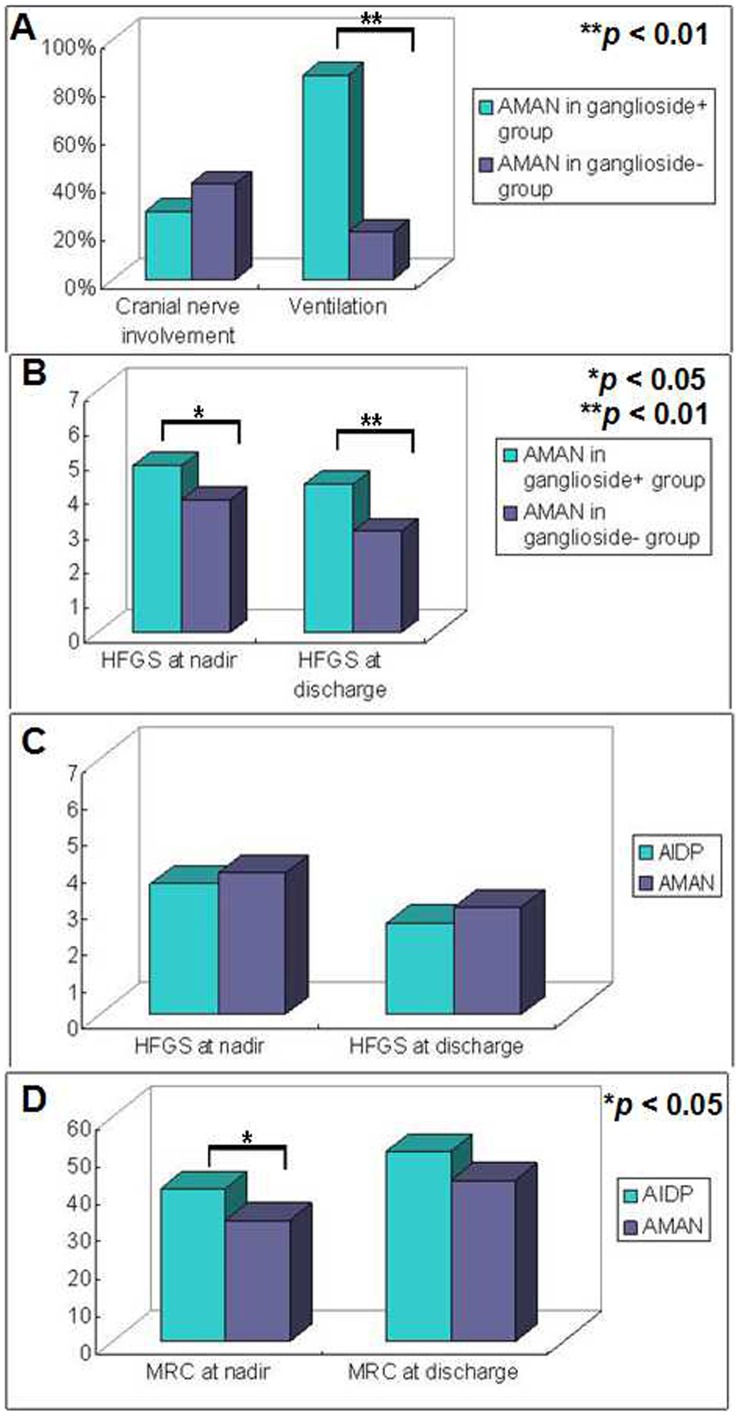
Stratified analyses of electrophysiological findings and functional deficits in patients according to subtypes (axonal form or demyelinating form) between the ganglioside+ and ganglioside− groups.
A. Two acute motor axonal neuropathy (AMAN) patients (28.6%) in the ganglioside+ group while 6 out of 15 (40%) in the ganglioside− group were found with bilateral facial nerves palsy. However, the frequency of cranial nerve involvement did not significantly differ in AMAN patients between the ganglioside+ group and ganglioside− group. The ventilation ratio was significantly higher in the ganglioside+ group when compared with that in the ganglioside− group (p<0.01). B. The scores of Hughes Functional Grading Scale (HFGS) were higher in AMAN patients in the ganglioside+ group both at nadir and at discharge suggestive of more severe clinical course and poorer short-term outcome. C. The scores of HFGS at nadir and at discharge were insignificantly different between patients with acute inflammatory demyelinating polyneuropathy (AIDP) and AMAN in the ganglioside− group (both p>0.05). D. The sum score of Medical Research Council (MRC) at nadir was significantly higher in patients with AIDP in the ganglioside− group than AMAN (p<0.05).